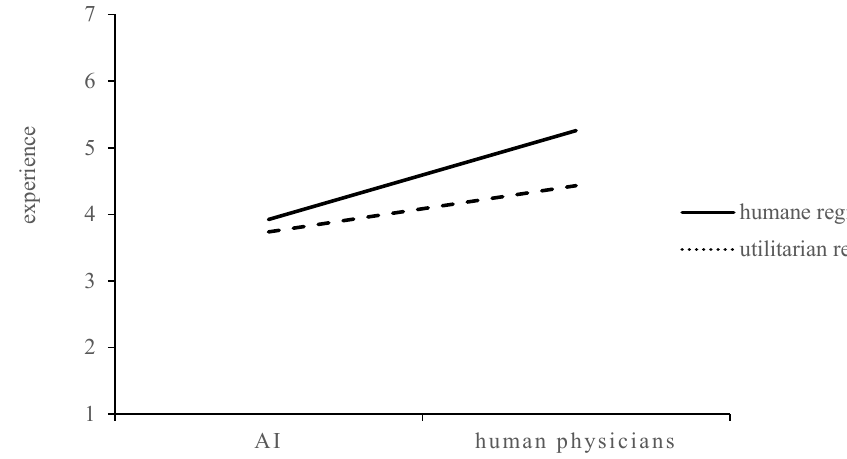
Figure 4. Sense of the regimen moderating effect to experience.